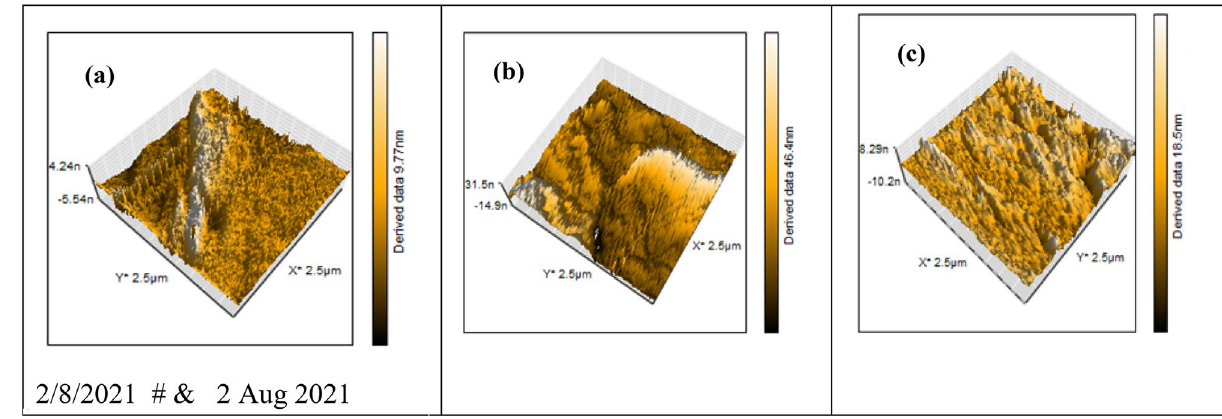
Figure 12. Three-dimensional AFM images for API 5L X70-type C-steel surface in 1 M HCl: ( a ) before immersion, (b ) in 1 M HCl (Blank) and ( c ) in 1 M HCl containing 500 µM of inhibitor MA-1740.